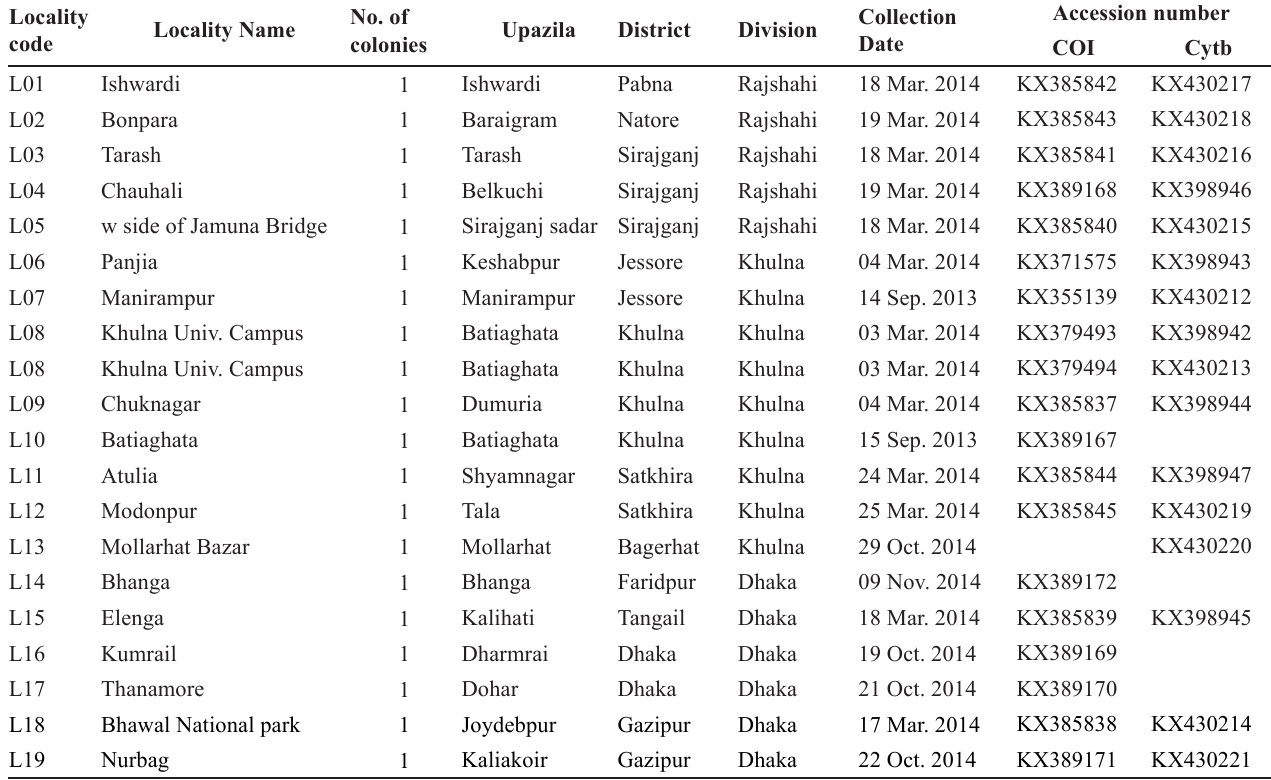
Table 1 . Specimen data and GenBank accession numbers. The list of